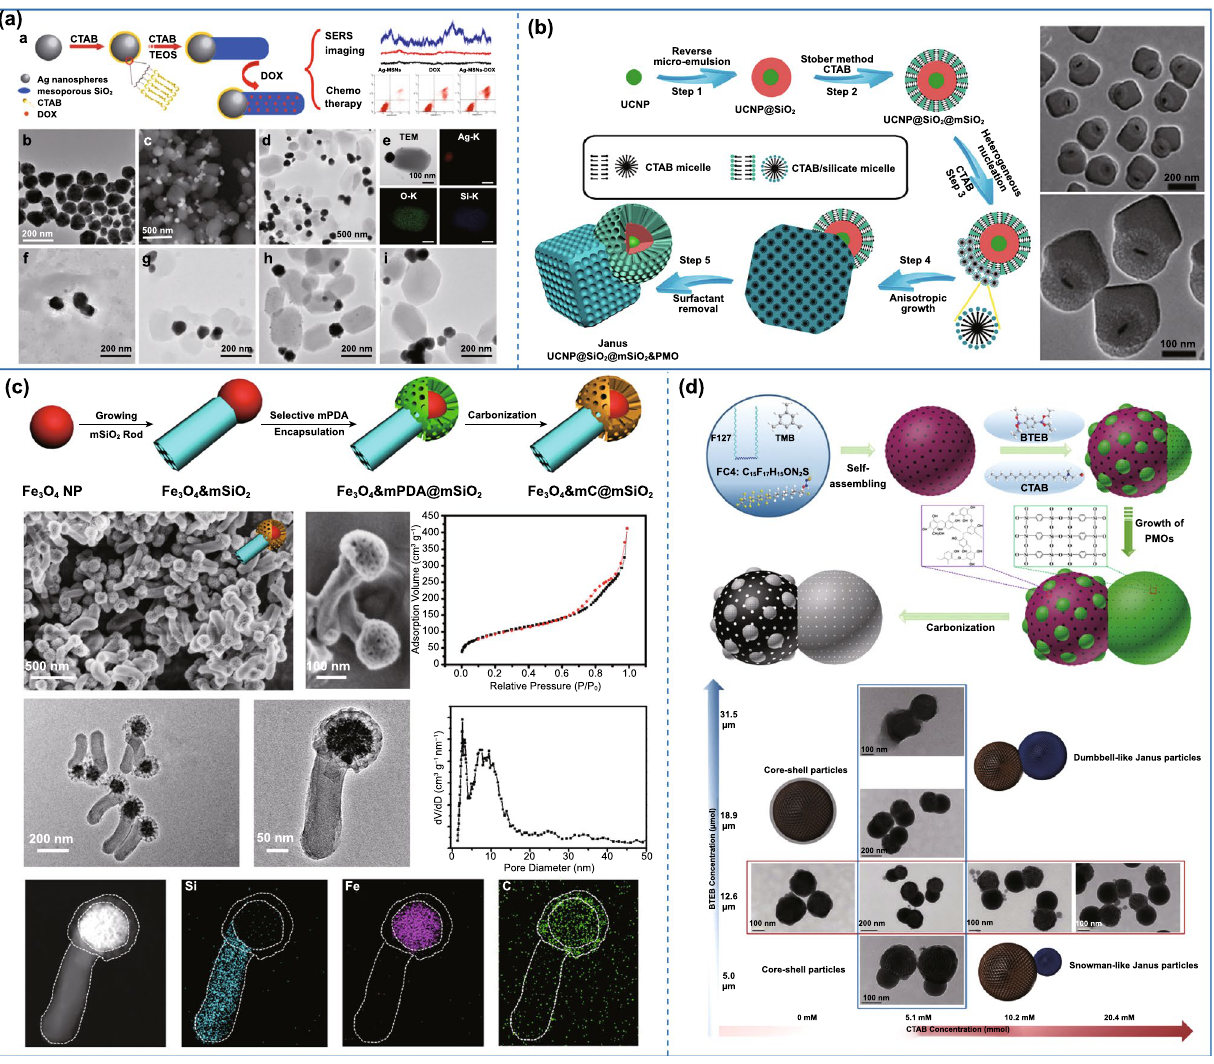
Fig. 9 Preparation of various asymmetric silica-based nanoparticles. a Fabrication of Janus Ag-silica nanoparticles through nucleation con- trol by the regulation of the reaction solvent. Reproduced with permission from Ref. [119]. Copyright 2016, American Chemical Society. b Preparation of the multifunctional dual-compartment Janus silica nanocomposites through nucleation control. Reproduced with permission from Ref. [122]. Copyright 2014, American Chemical Society. c Fabrication of Janus structure through interface modification and nucleation control. Reproduced with permission from Ref. [125]. Copyright 2018, American Chemical Society. d Preparation of Janus structure by regulating the concentration of surfactants. Reproduced with permission from Ref. [120]. Copyright 2017,